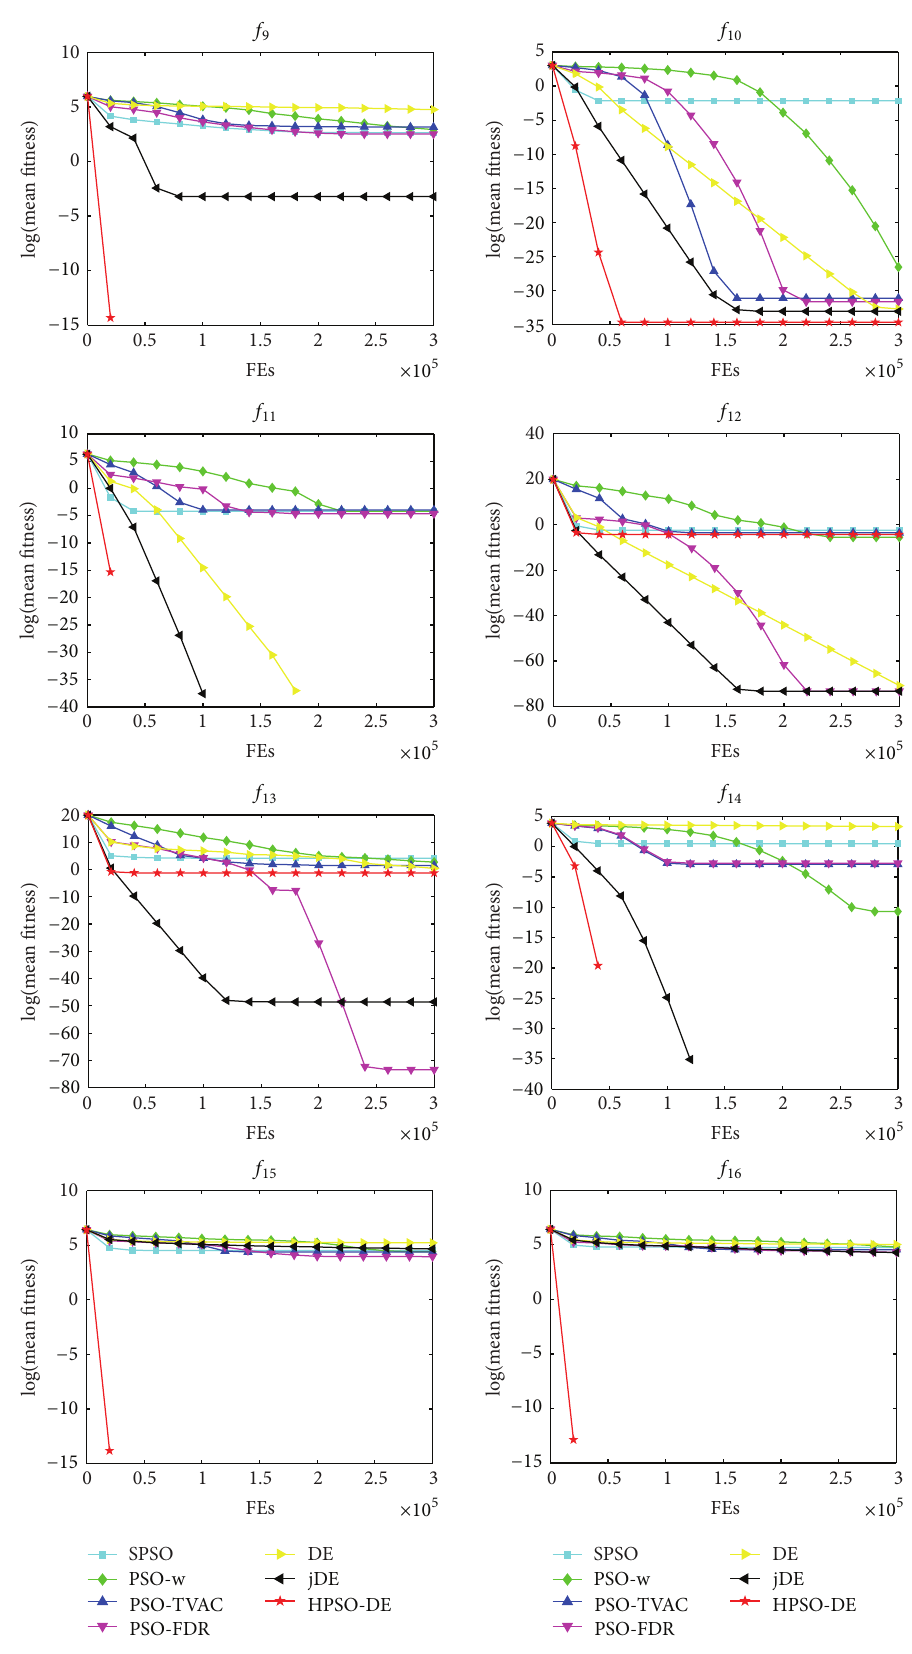
Figure 2: Performance of the algorithms for 𝑓 9 , 𝑓 10 𝑓 11 , 𝑓 12 , 𝑓 13 , 𝑓 14 , 𝑓 15 , and 𝑓 16